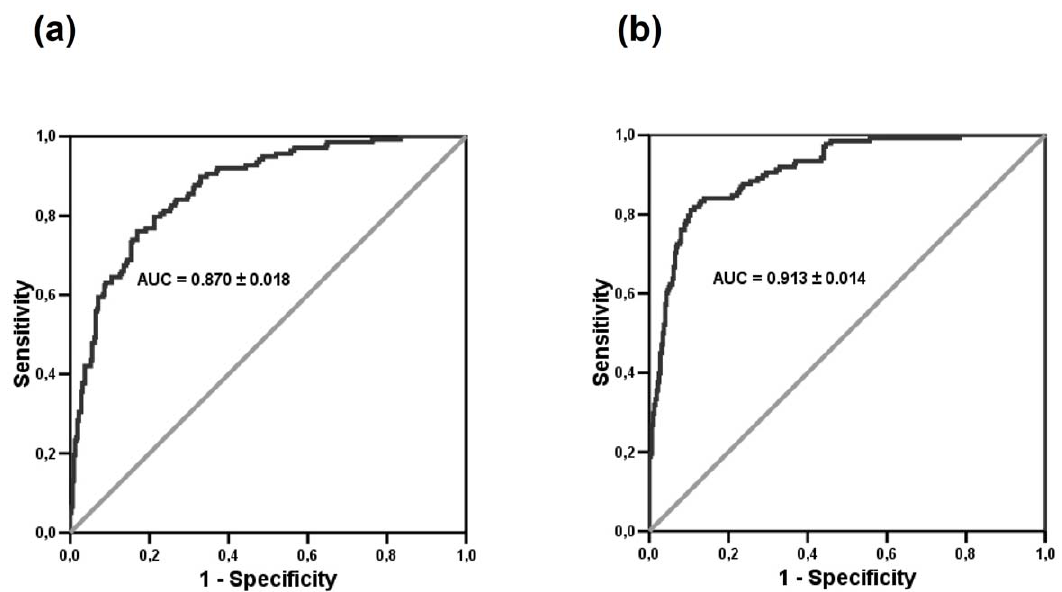
Figure 2. ROC curves of the predictive power of the (a) ICAR and (b) ML models.